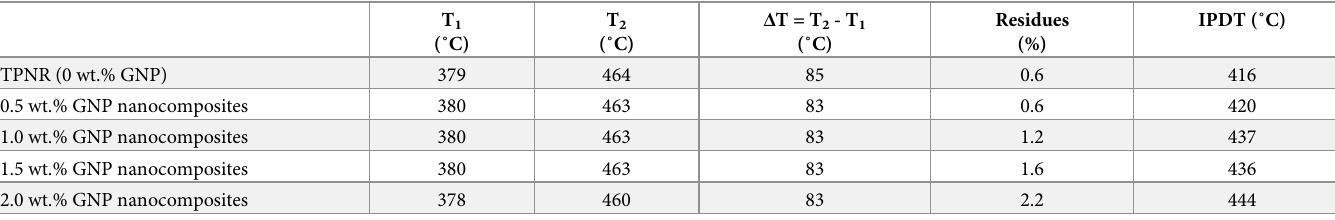
Table 1. Thermal stabilities of TPNR and TPNR/GNP nanocomposites obtained from TGA.